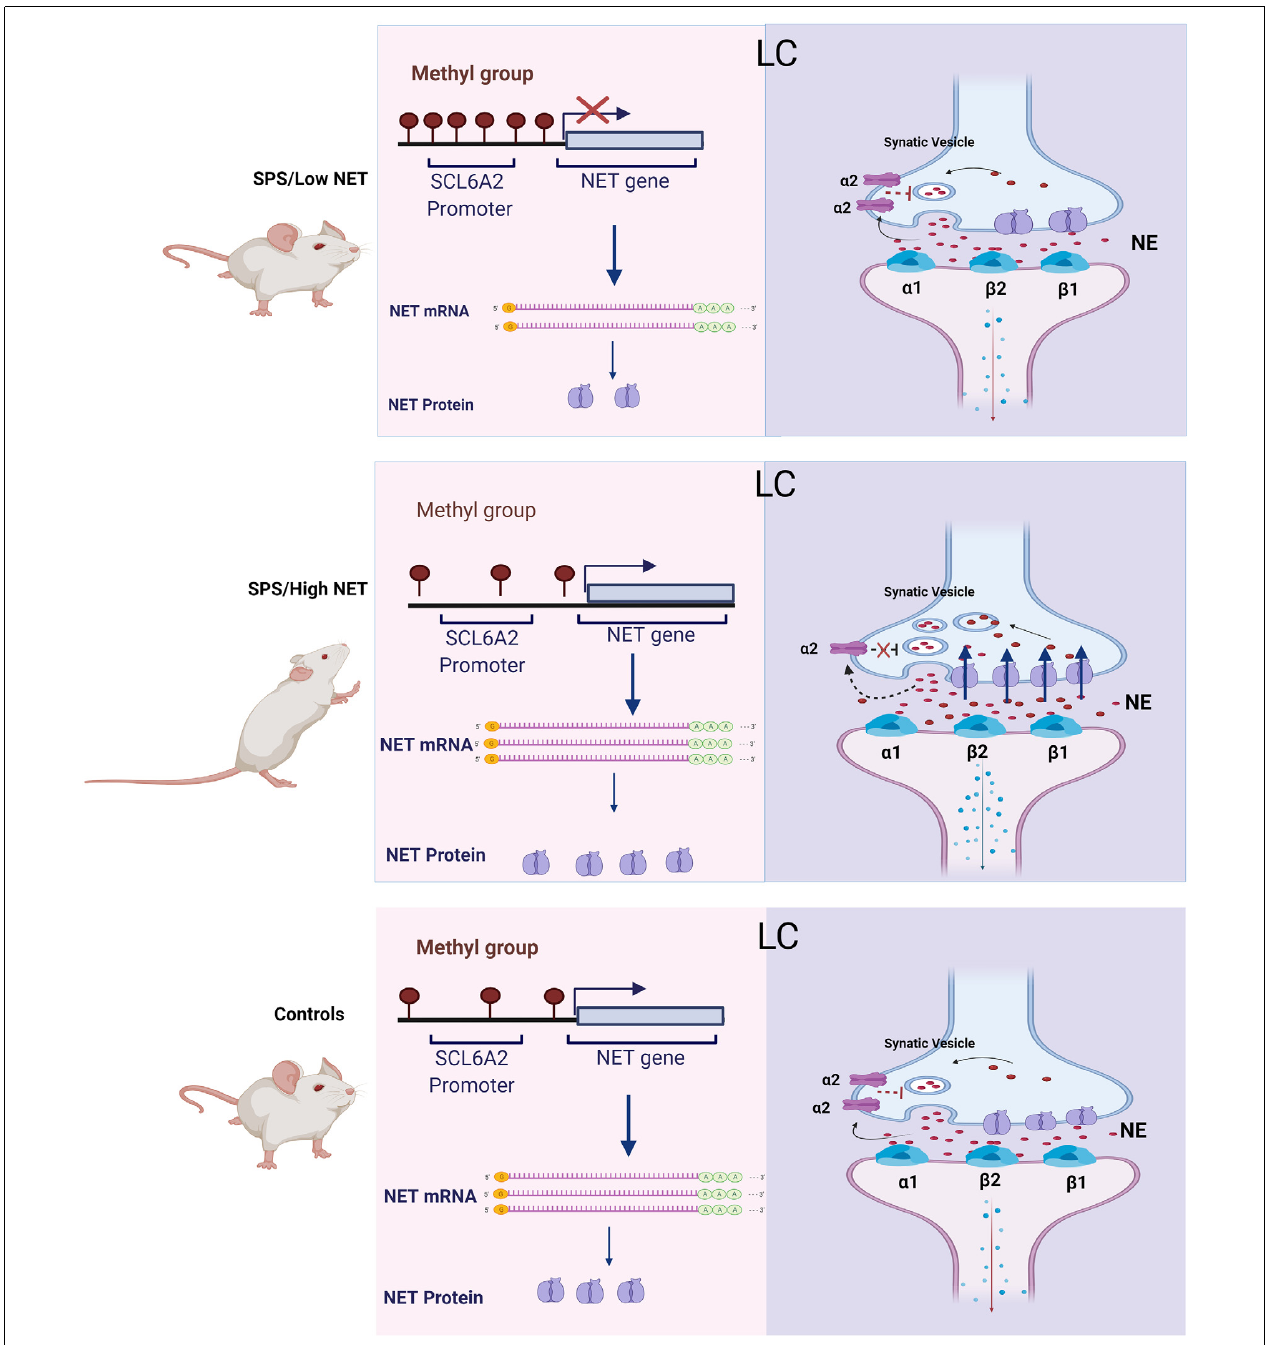
FIGURE 5 | Scheme for changes in NET gene expression and proposed mechanism of differences in activation of the LC in the SPS/LowNET, SPS/HighNET and unstressed control groups. The levels of NE in the synapse are determined by changes in NE synthesis, NET gene expression and auto inhibition at presynaptic cells.